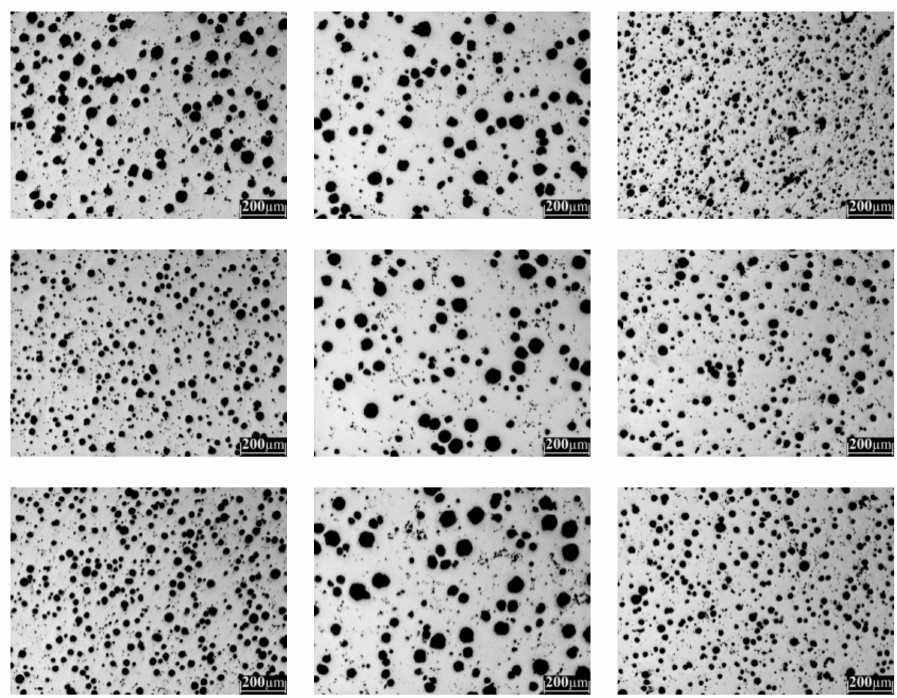
Figure A2. Unetched microstructure of the ductile iron alloyed with 0.3 wt % V for different lobes and regions.